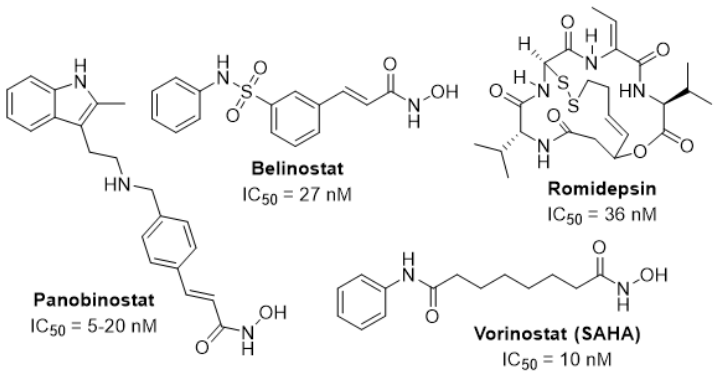
Figure 2. FDA-approved histone deacetylase (HDAC) inhibitors [50].